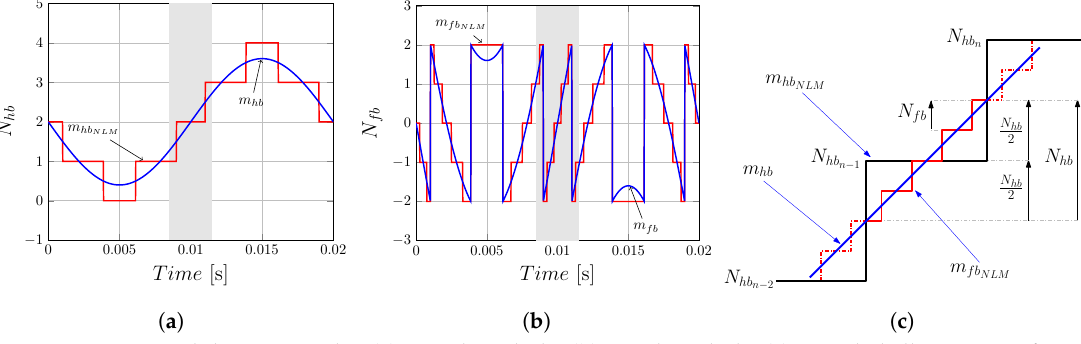
Figure 3. Modulation signals: ( a ) HB chain-link; ( b ) FB chain-link; ( c ) Detailed illustration of modulation